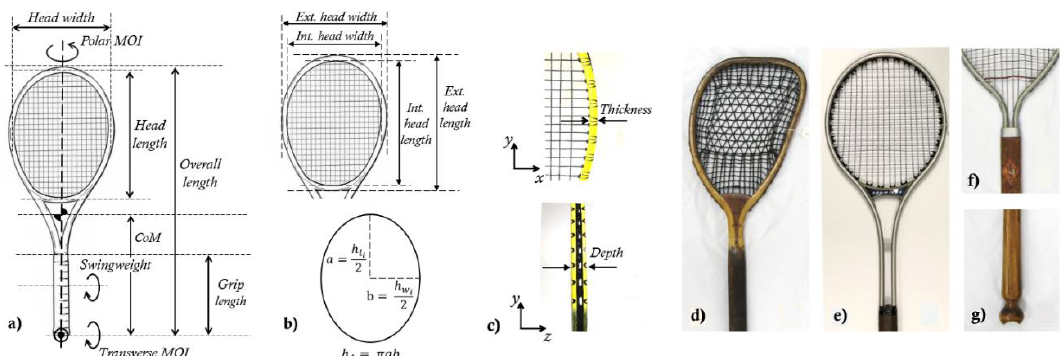
Figure 1. ( a ) Diagram showing the measured geometric and mass properties and moments of inertia (MOI) of a tennis racket; ( b ) Diagrams showing the racket head measurements and the definition of head area (h a ); ( c ) photographs showing the definitions of frame thickness and depth; ( d ) a wooden racket with a lopsided frame, flat top head and a convex wedge in the throat section, showing an Egyptian stringing pattern; ( e ) an aluminium racket with a circular head and a twin shaft throat with an extra yoke and an insert made of a different material (plastic); ( f ) a throat section with no yoke, typical of Dayton steel rackets; and ( g ) an example of an ornate, “fish-tail” handle of an old wooden racket. Table 1. Properties documented and measured for each racket.